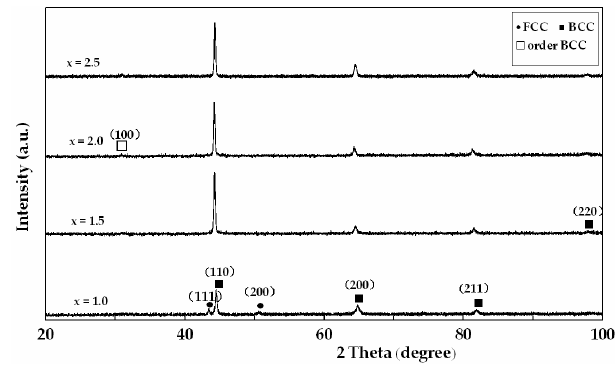
Figure 3. X-ray diffraction patterns of Al x CoCrFeNiTi 0.5 HEA coatings.